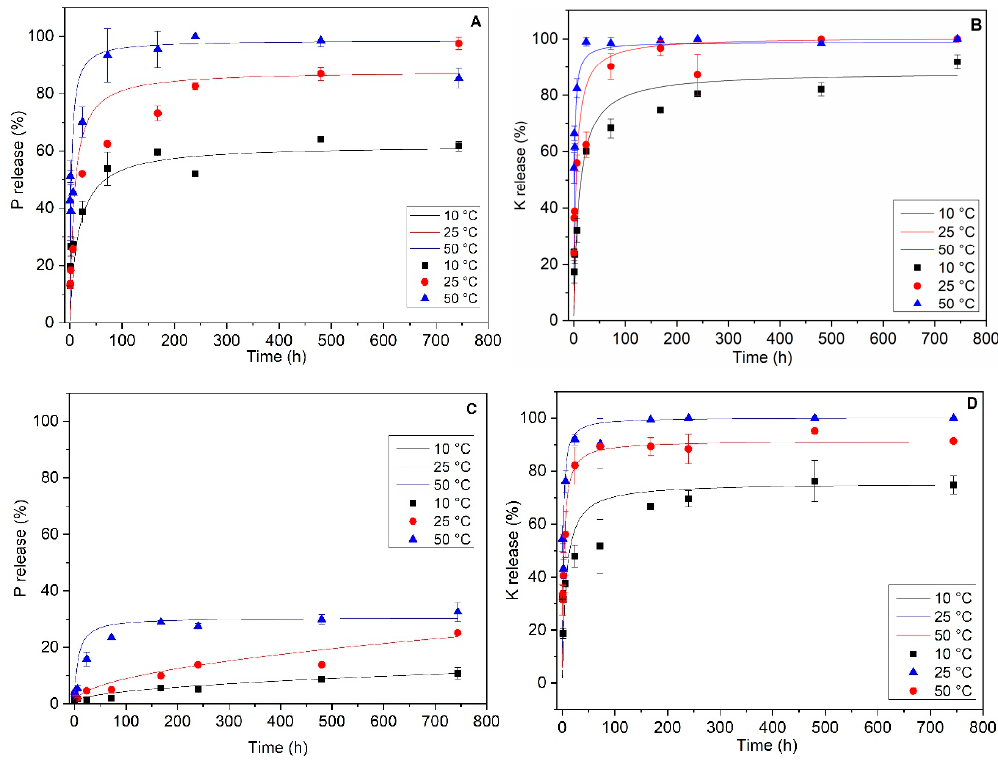
Figure 6. P ( A,C ) and K ( B,D ) release assays for MgAl 200 /K 2 HPO 4 ( A,B ) and MgFe 200 /K 2 HPO 4 ( C,D ). The symbols correspond to experimental data and the curves show the corresponding fit. Constant rate values of K and P releases were in the same range of values between 0.0702 min − 1 and 0.519 min − 1 even though they were not correlated with each other. Obviously, in the MgAl 200 /K 2 HPO 4 composite, K + and HPO 42 − are no longer linked in a single phase. Milling forced both